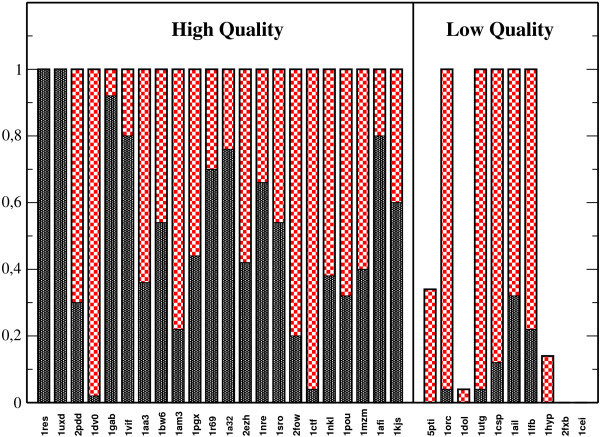
Enrichment. Enrichment of native conformations by PFF01: Fraction of near-native conformations in the top 50 decoys by energy (black) and by CαRMSD (red). The latter bar indicates the enrichment attainable by an 'ideal' scoring function.